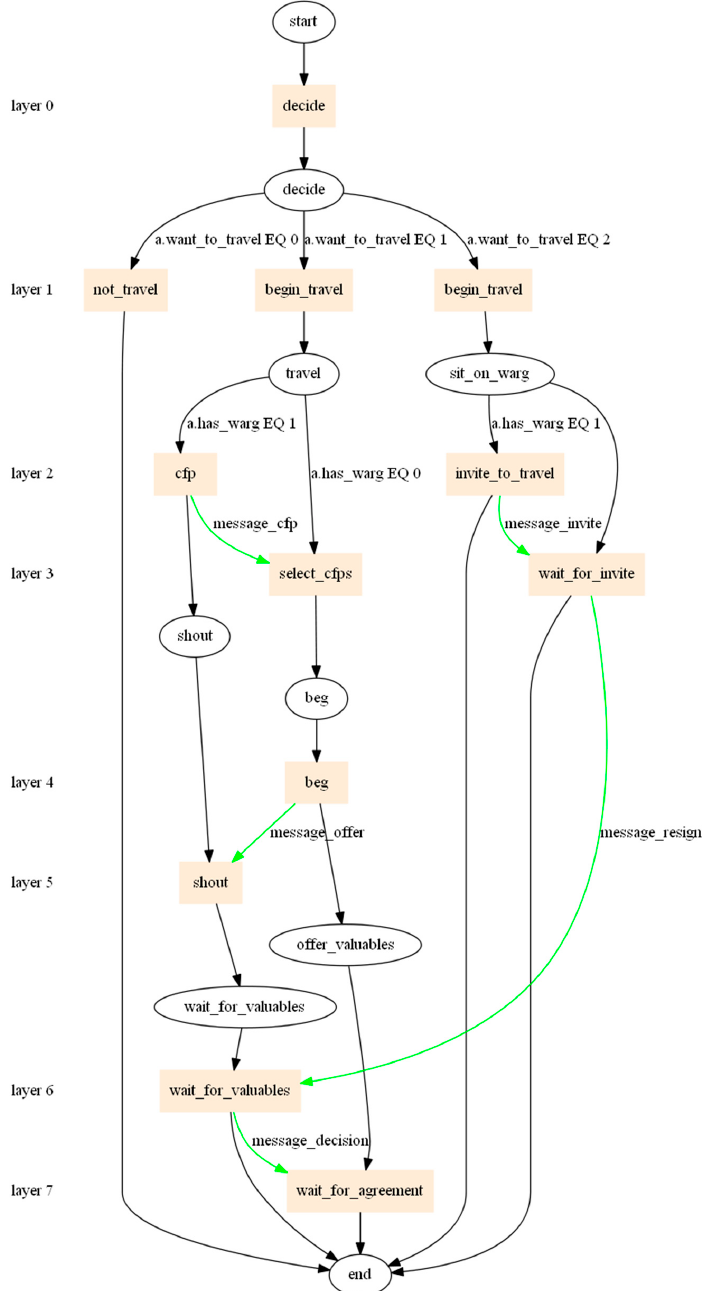
Figure 8. Flow of the agent’s actions. The flow represents five roles and the exchange of messages. Source: the authors’ own elaboration.